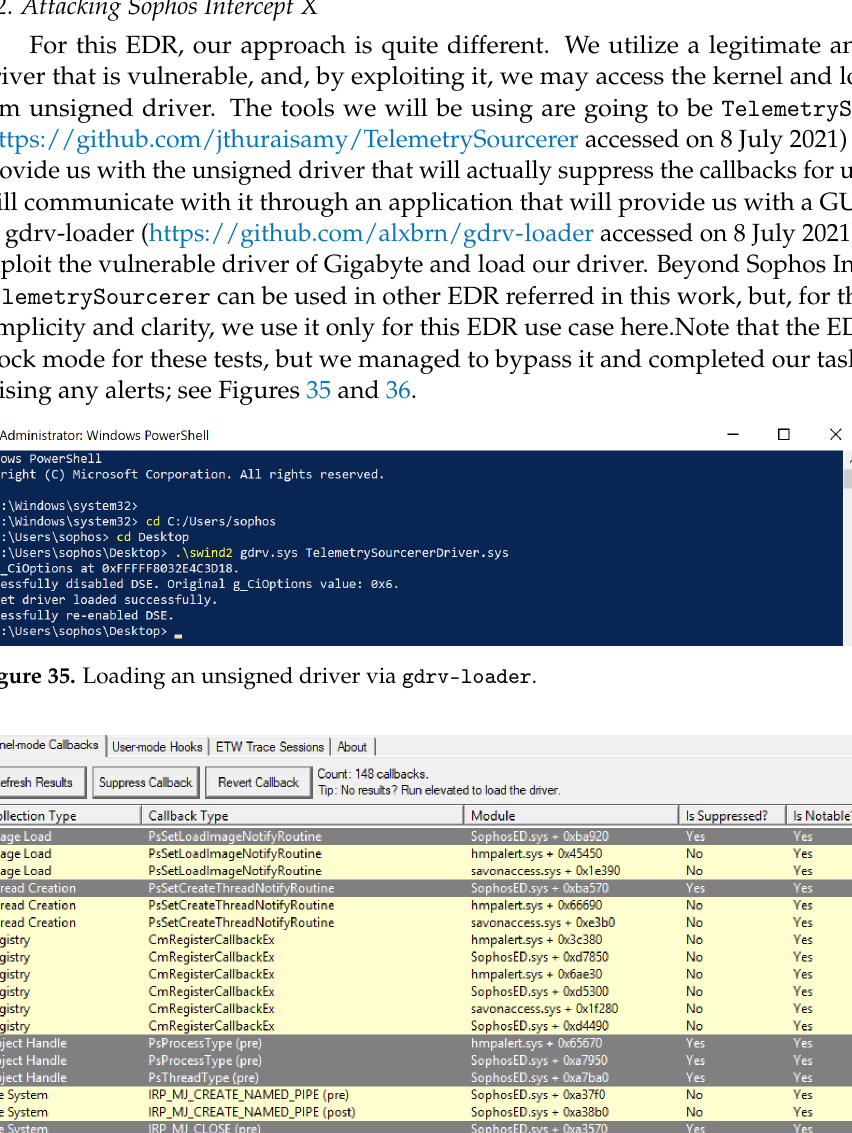
Figure 34. Sample Alert caused by Dumpert .